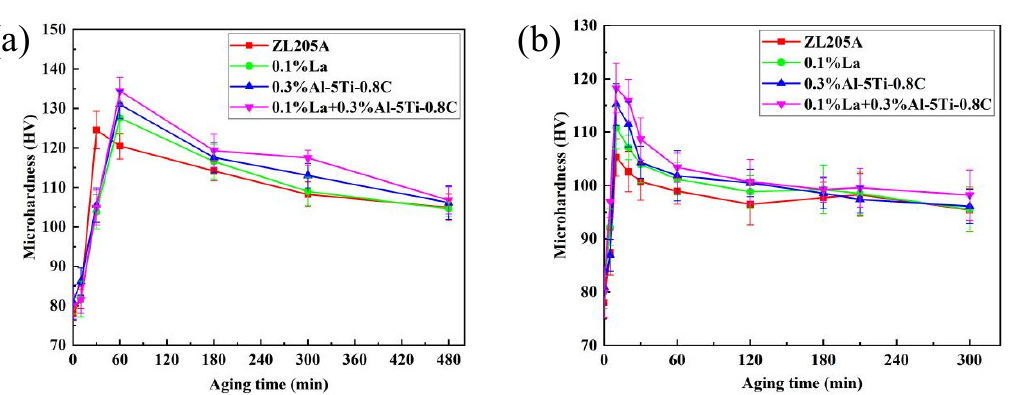
Figure 12. Isothermal age–hardening curves of ZL205A alloy at ( a ) 250 °C and ( b ) 300 °C. The age–hardening curves at an aging temperature of 300 °C are shown in Figure 12b. The time to peak hardness at 300 °C was 10 min for both the unmodified alloy and the alloy with 0.1%La and 0.3%Al–5Ti–0.8C. The peak hardness was 105HV for the unmodified alloy, 111HV for the alloy with 0.1%La, 115HV for the alloy with 0.3%Al–5Ti–0.8C, and 118HV for the composite. The peak hardness of the alloy with 0.3%Al–5Ti–0.8C and 0.1%La was 118HV. The peak hardness of the alloy with 0.1%La + 0.3%Al–5Ti–0.8C was higher than that